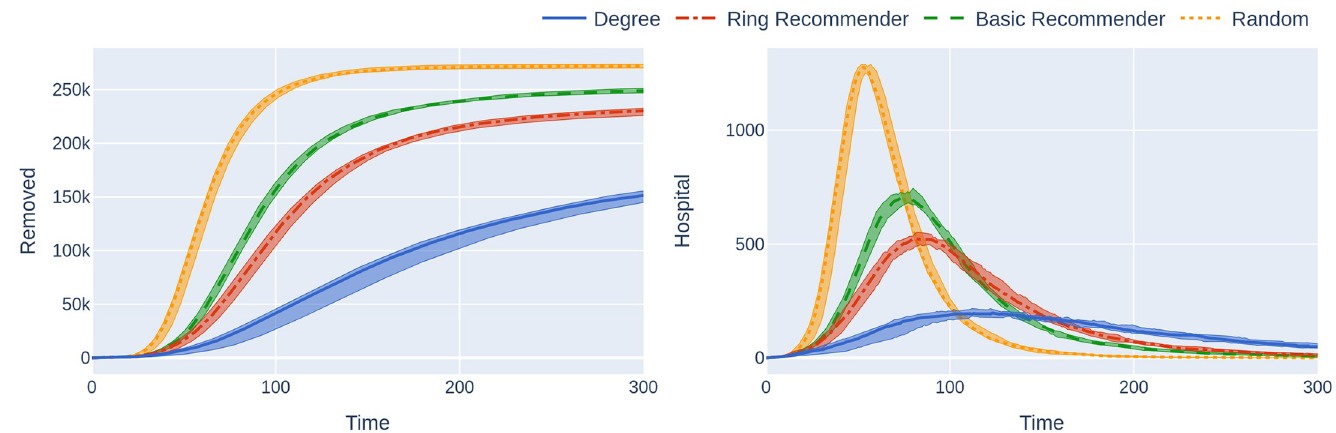
Fig 3. Simulations of an epidemic on a 500,000 node GIRG network with few super-spreaders ( τ = 3.3) and less geometry ( α = 1.3), with uptake percentage p % = 55%. The x -axis shows the time steps over which the epidemic is simulated. The y -axis of the left figure shows the number of removed individuals over the course of the epidemic. The y -axis of the right figure shows the number of hospitalised individuals over time (in the same simulation). The plotted curves correspond to the median over 20 runs (in the four scenarios); the shaded area covers the 25th-75th percentile of these runs over time. The left figure shows that the random uptake scenario is outperformed by all other scenarios and has a steeper incline, leading to a situation where more people get infected. The right figure shows that the number of hospitalised individuals is also higher under the random uptake scenario. This figure corresponds to the p = 55% value in the first two rows of the leftmost column of Fig 2. Similarly to the situation regarding that figure, the epidemic is started by infecting 100 individuals, chosen uniformly at random. Simulation is halted when there are no more exposed or infected vertices. For completeness the simulations use β = 0.05 and q = 0.6.